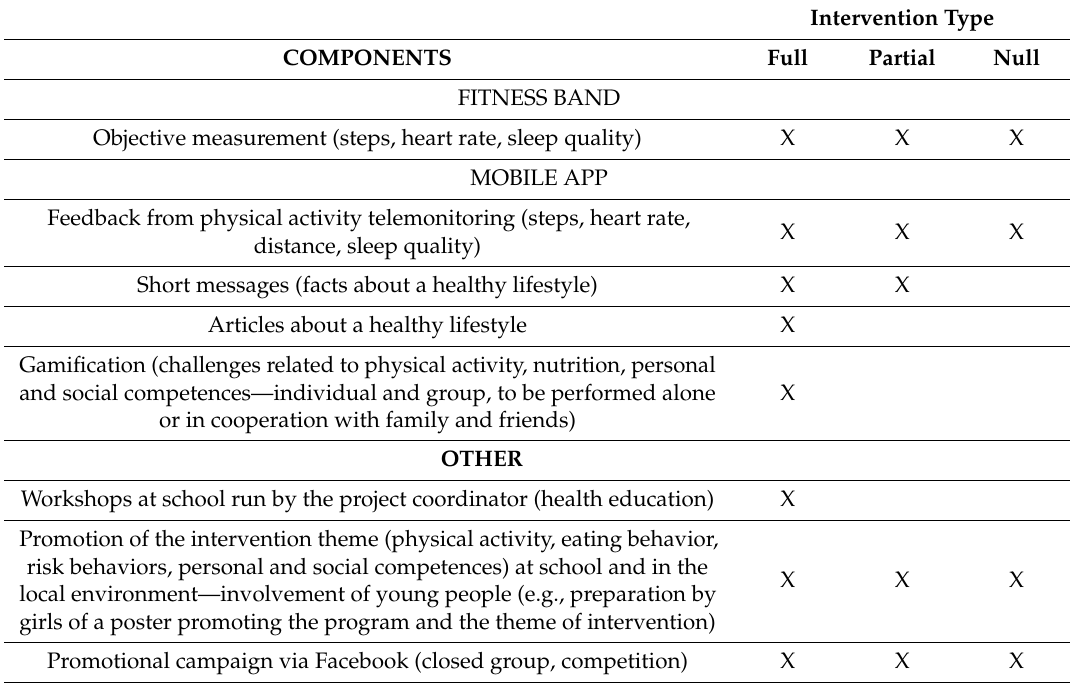
Table 1. Intervention components by type of